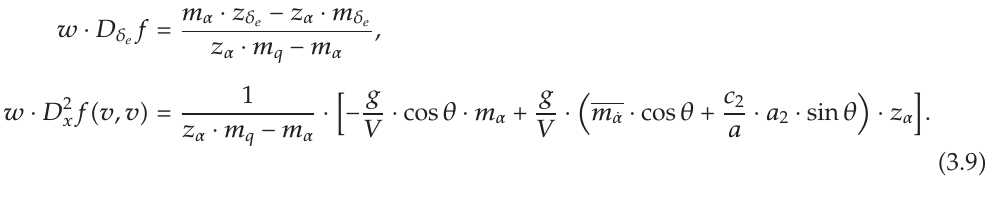
Figure 7: Resetting δ e from δ (cid:6)(cid:6) oscillations a stable equilibrium is